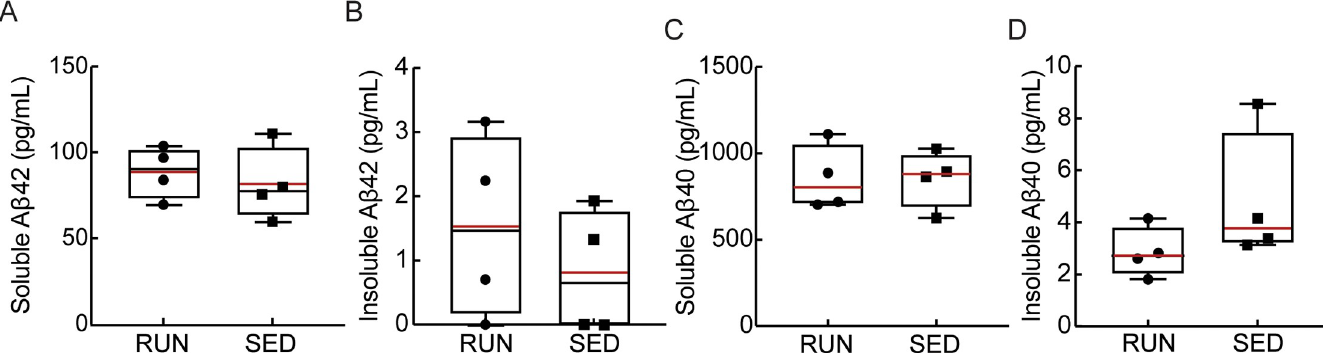
Fig 5. Running did not alter the levels of soluble and insoluble amyloid beta monomers in the brain. Soluble (A and C) and insoluble (B and D) concentrations of A β 1–42 (A and B) and A β 1–40 (C and D) in brain lysates from running (RUN) and sedentary (SED) APP/PS1 mice, as measured using ELISA assays.